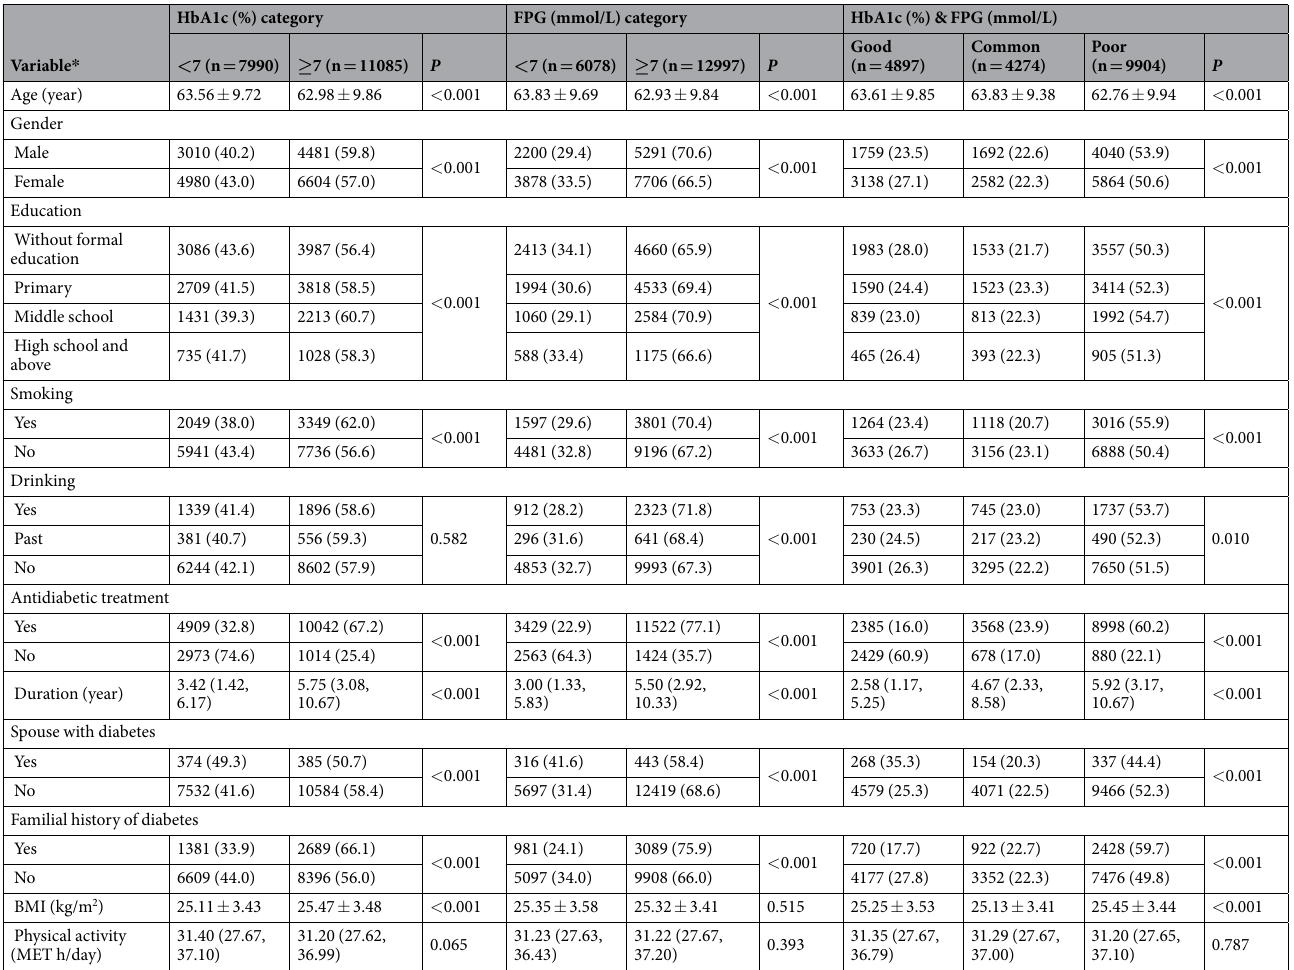
Table 1. Characteristics based on different glycaemic control status using HbA1c and FPG. Continuous variables were presented as the means (SD), and categorized variables as numbers (percentages). P values were from one-way analysis or Mann-Whitney U test for continuous variables and from chi-squared test for categorical variables. * There were 68 missing values for education; 57 missing values for drinking; 137